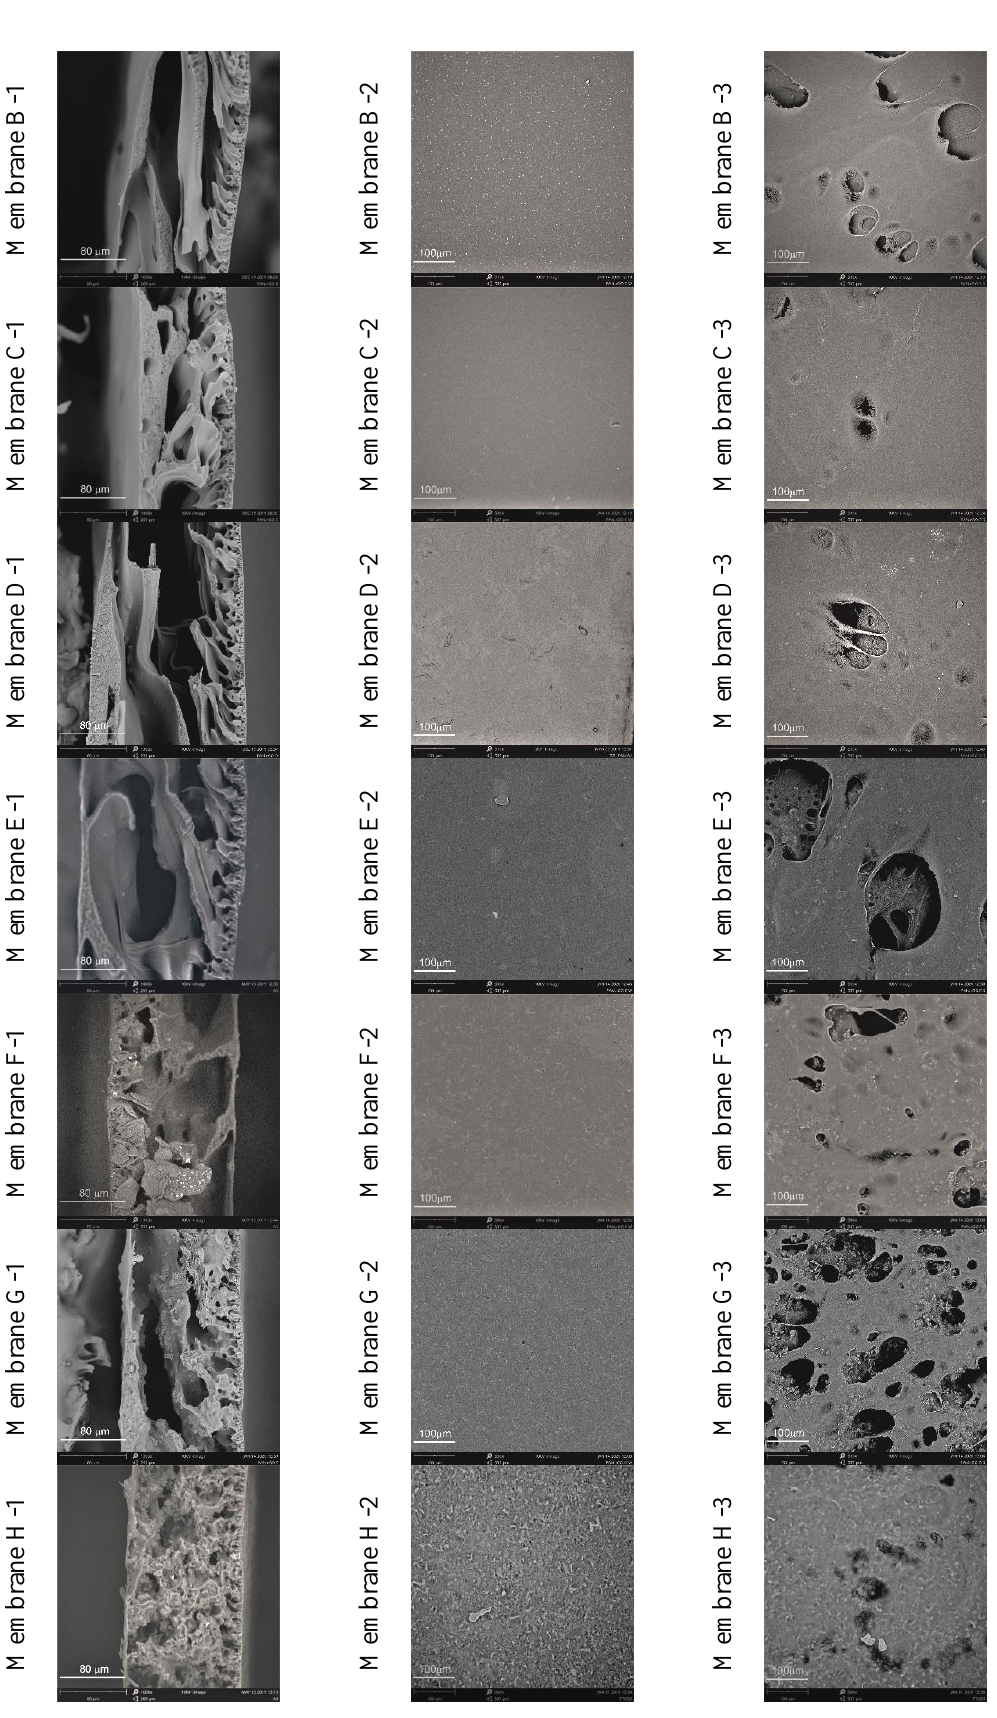
Figure 3. Images (SEM) of pure PAN and rGO / PAN composite membranes: ( 1 ) Cross-section; ( 2 ) top (skin) layer; ( 3 ) bottom